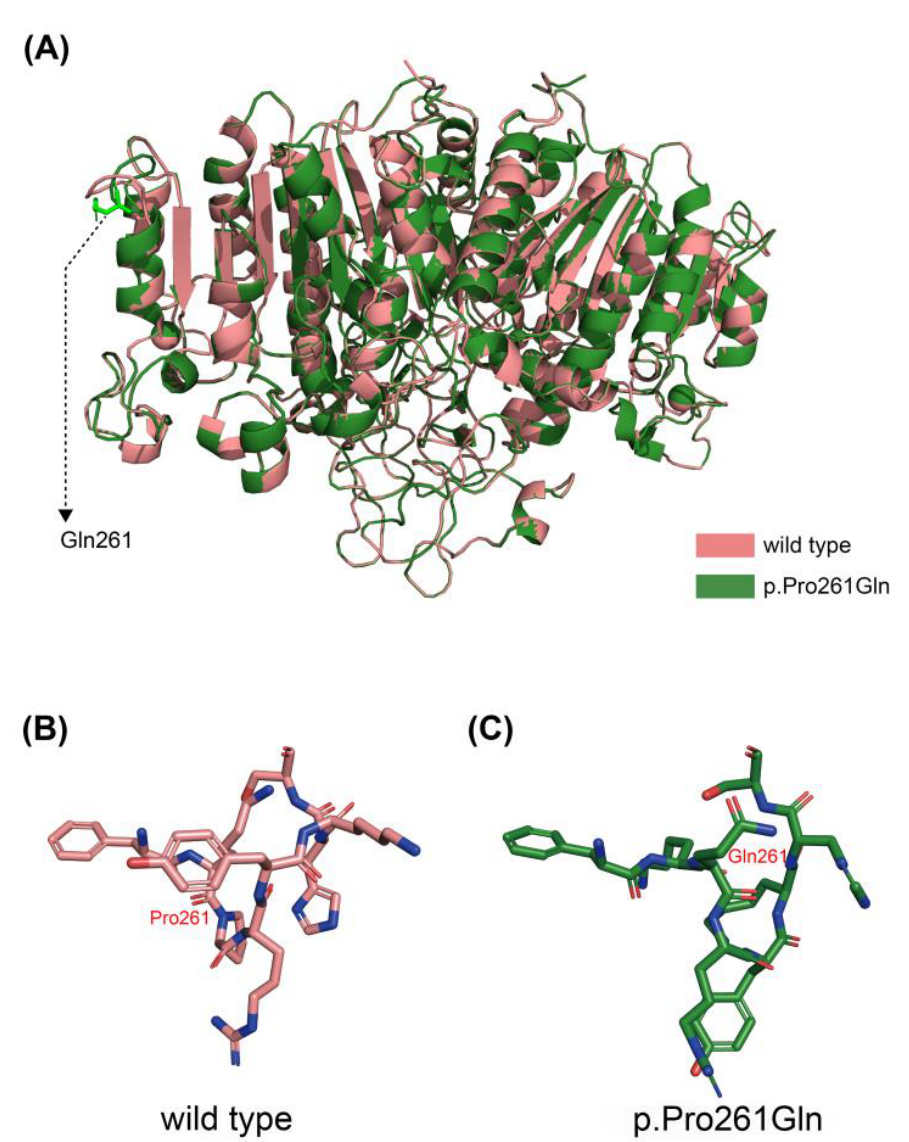
Figure 5. Three-dimensional structures of wild-type and Pro261Gln TNSALP constructed by Swiss- model. ( A ) Alignment of wild-type TNSALP and p.Pro261Gln mutant. ( B , C ) Intramolecular analysis of wild-type and mutant TNSALP, with no new interactions